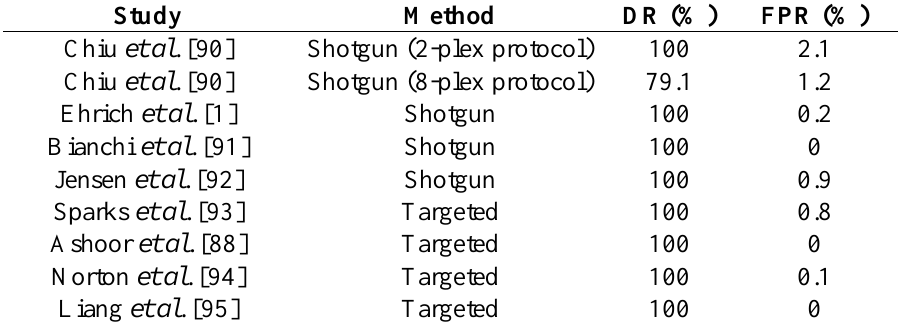
Table 2. Clinical trials of NIPT by massively parallel sequencing (MPS) for fetal DS (adapted from